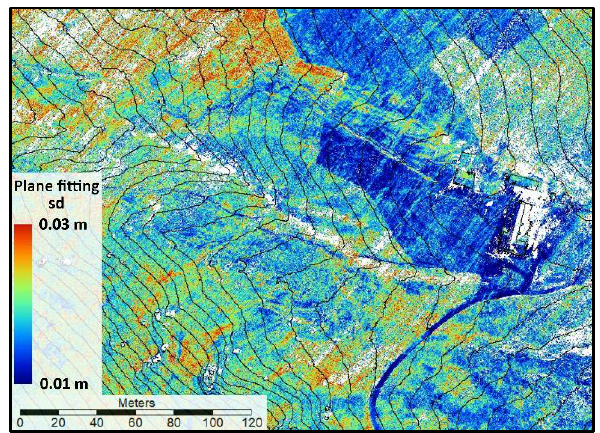
Figure 7. Total standard deviation ( plane fitting sd ) of the planes fitted in both point cloud epochs filtered with t pe = 0.04 m.